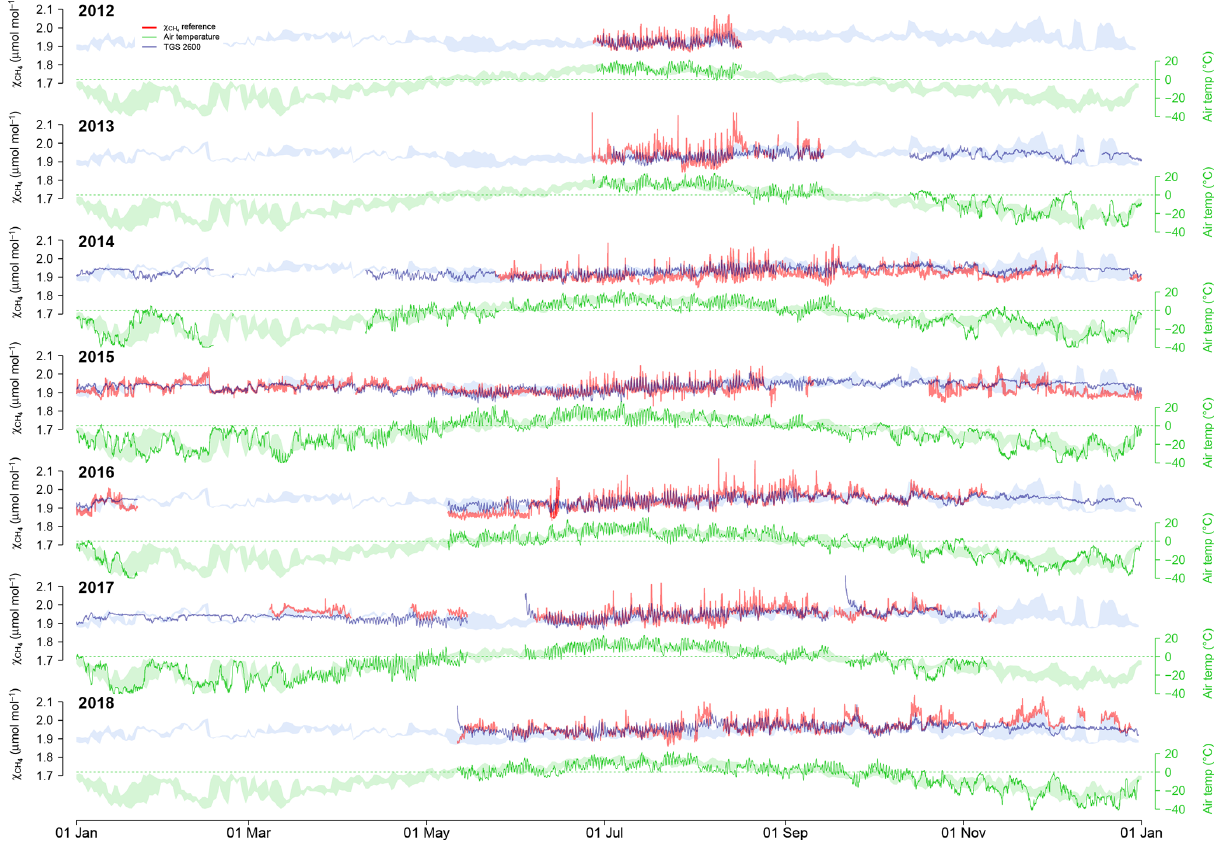
Figure 4. Overview over annual courses of 30min averaged air temperature (green) and CH 4 mole fractions (blue and red). Pale color bands show the daily interquartile range (50% of values between the first and third quartiles) of measurements from all years. Solid lines show actual measurements. Red lines are the reference CH 4 measurements, and blue lines show the CH 4 mole fraction derived from TGS 2600 measurements (sensor 1). Actual measurements show 30min mean